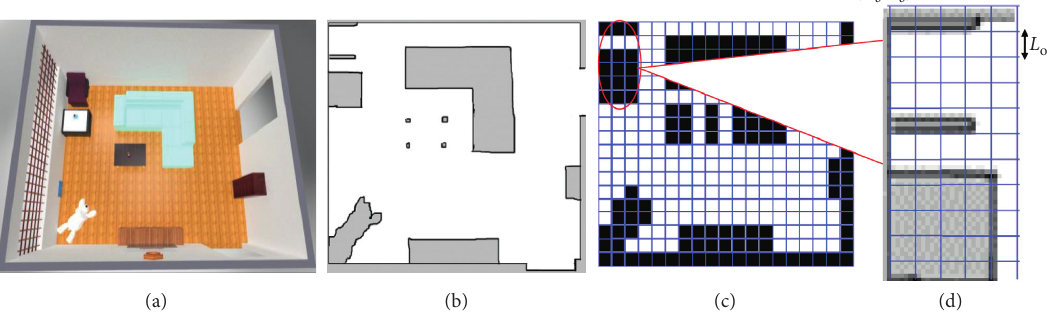
Figure 4: Explanation of the method proposed for determining the optimum block size. (a) Environment to be covered. (b) Metric map of the environment. (c) Occupancy grid map when cell size is L U . (d) Segmented metric and placement of grid for coverage of the obstacle